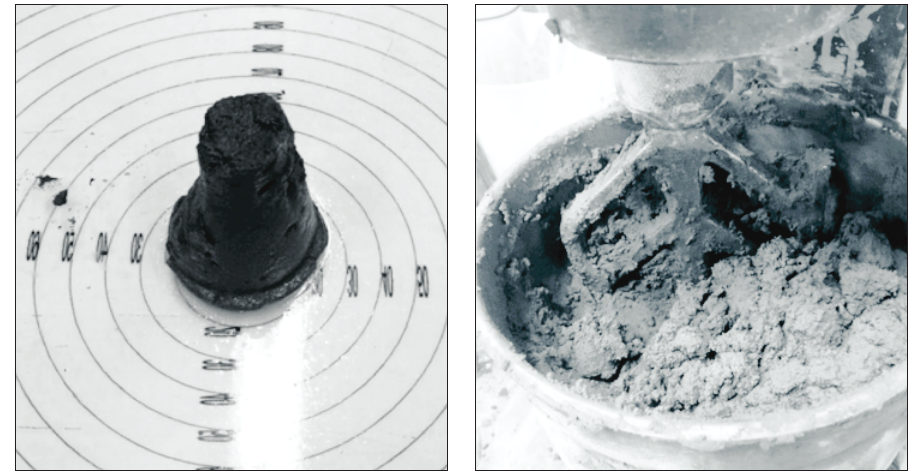
Pasta de sílica ativa, com relação a/s igual a 1 e teor de aditivo superplastificante igual a 3% m.c.